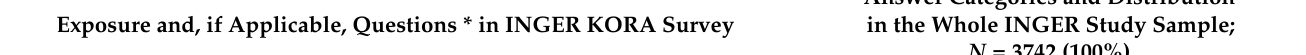
Table 2. Exposure distribution within the INGER